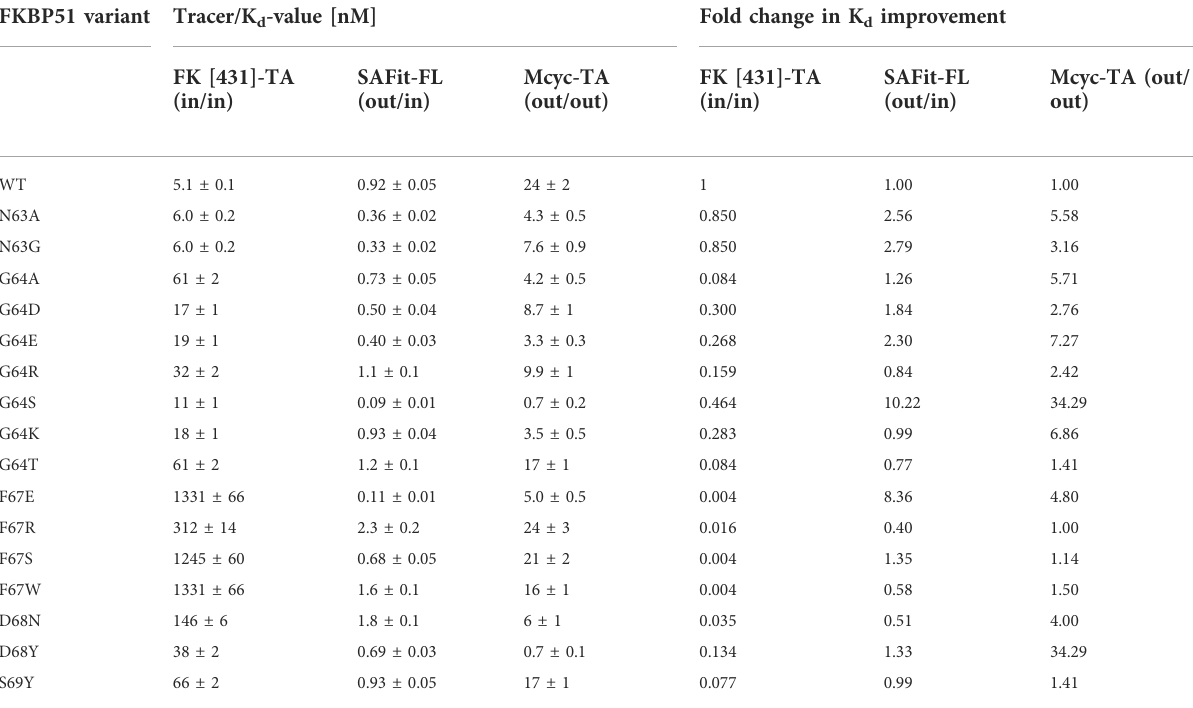
TABLE2Ligandbindingaf fi nitiesmeasuredby fl uorescencepolarizationandfoldchangeinKdimprovementwiththecanonicalFK[431]-TA (in/in) and the two FKB51 speci fi c tracers (SAFit-FL (out/in) and Mcyc-TA (out/out) ). FKBP51 variant Tracer/K d -value